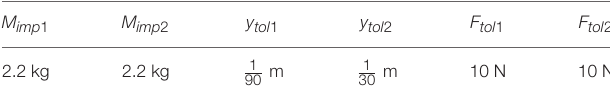
TABLE A2 | Experimental values of the SOIC